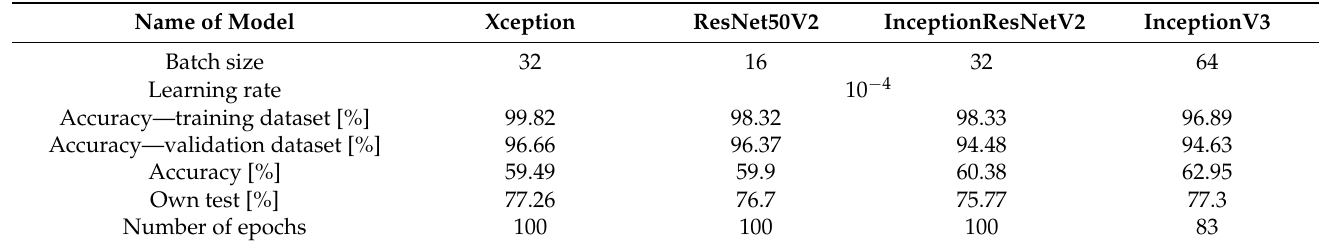
Table 8. Results of the second stage of the NN